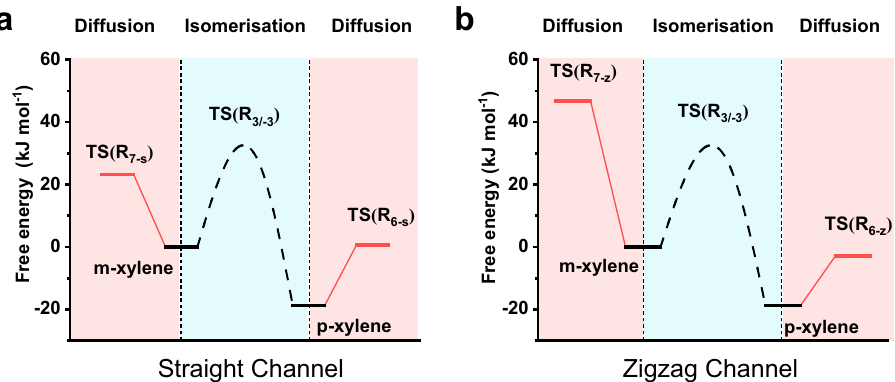
Fig. 8 Competition between diffusion and isomerization of xylenes in HZSM-5. The simpli fi ed mechanistic framework of toluene methylation to p-xylene and m-xylene by combing the isomerization and diffusion along a straight and b